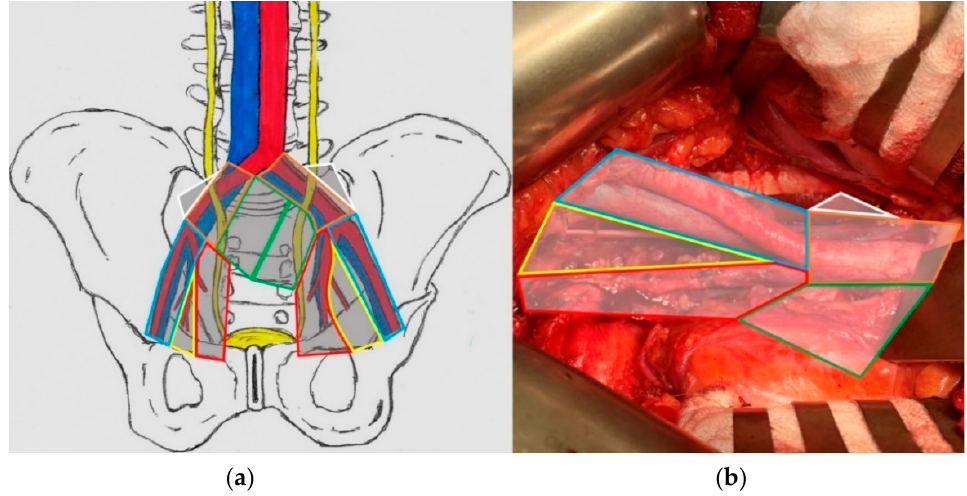
Figure 3. The template of modified-extended lymphadenectomy in the scheme ( a ) and during surgery ( b ); blue—external iliac region, yellow—obturator fossa region, red—internal iliac region, green— presacral region, orange—common iliac region, white—Marcille’s fossa (lying behind the plane).